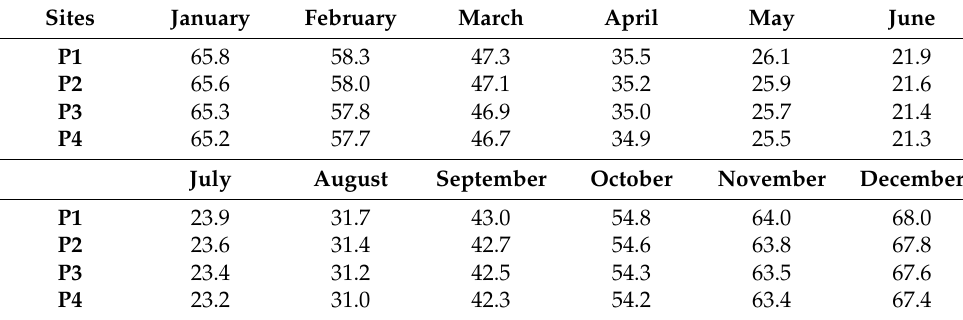
Figure 5. The annual variation in tilt angle. Table 2. Monthly optimum fixed tilt